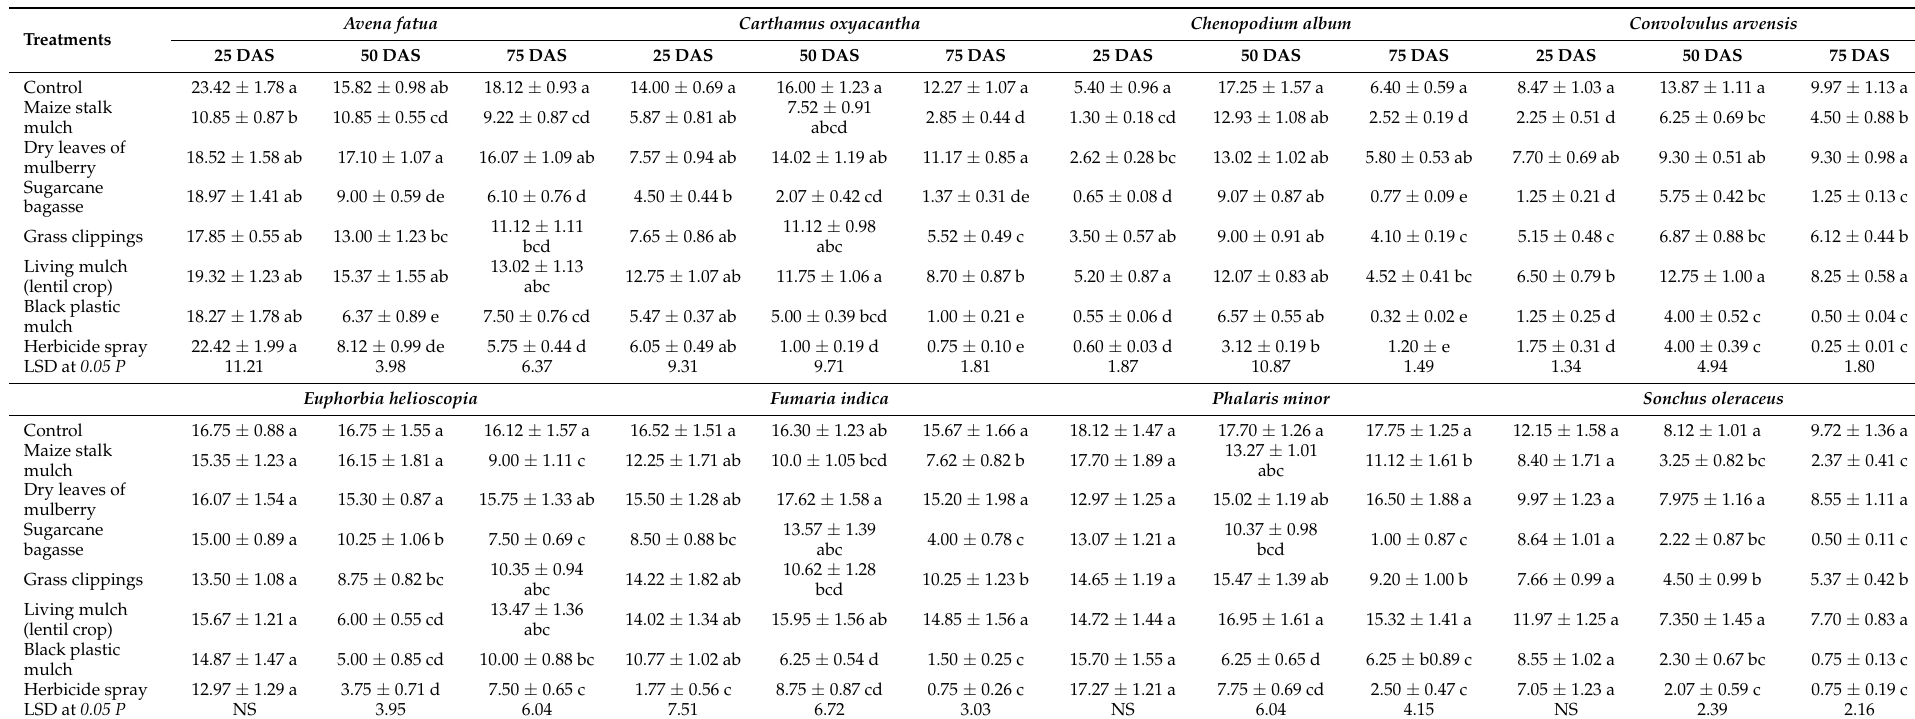
Table 2. Effect of various mulch materials on relative weed density (%) of different weed species of